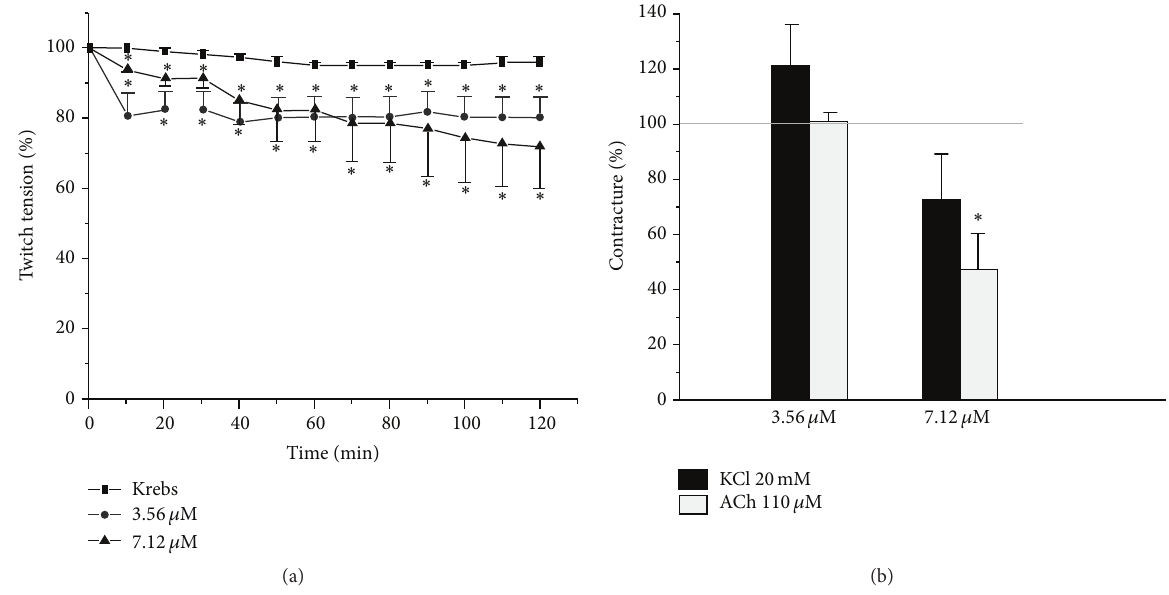
Figure 8: Twitch-tension response curve of indirectly stimulated BC preparations incubated with 3.56 and 7.12 𝜇 M (50 and 100 𝜇 g/mL, resp.) at 37 ∘ C. (a) Each point represents the mean ± SEM of 3–6 experiments. (b) Percentage of Ach (110 𝜇 M) and KCl (20 mM) evoked contracture after Bp-13 administration; ∗ 𝑃 < 0.05 compared to control values. ANOVA and followed by Mann-Whitney test for comparison between two